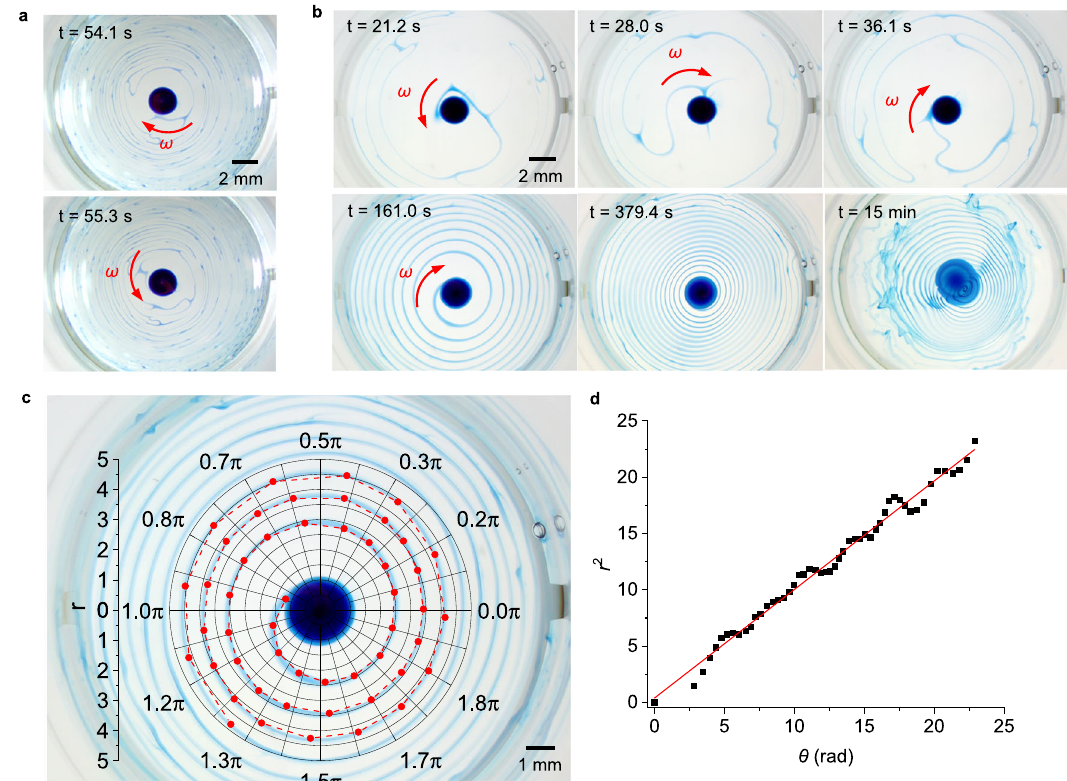
Fig.3|FormationandcalculationofFermat ’ sspiralpatterns.a Theformationof maze-like patterns by random rotation switching between clockwise and counter- clockwise after the addition of a DEX-MB-CaCl 2 (50mM) droplet to a round cell (diameter 15.8mm) fi lled with PEG-SDBS (7mM) solution. The red arrows indicate the rotation direction of the fi lament. Images were obtained from Supplementary Movie 2. b Surface patterns as a function of time after the addition of a DEX-MB-